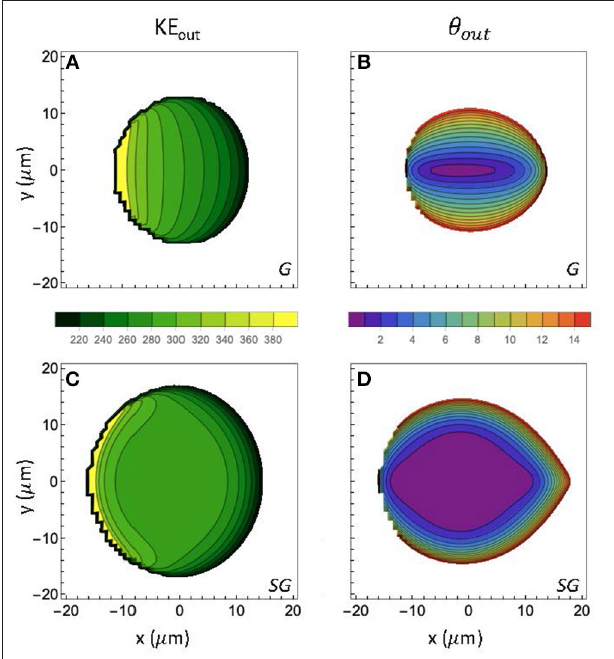
FIGURE 7 | Single particle calculations of electron acceleration from a finite beam with radius 20 µ m , a pulse duration of 20fs, a 60 ◦ PFT angle, and 200 keV peak ponderomotive potential. In the first row we calculate, as a function of the initial electron coordinate ( X 0 , Y 0 , Z 0 = 0) and for a Gaussian (G) transverse beam intensity profile, the output (A) kinetic energy, KE out and (B) the output angle, relative to the 60 ◦ direction of the force. The second row (C,D) shows the corresponding calculations for a super-Gaussian (SG) transverse beam profile. As indicated in the legends, the contour spacing for the energy plots is 20 keV and angle is 1 degree.